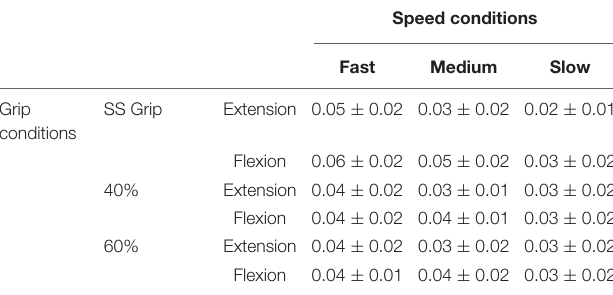
TABLE 4 | Stiffness parameter K (Nm/rad) for the RH of the healthy population and for the nine experimental conditions.